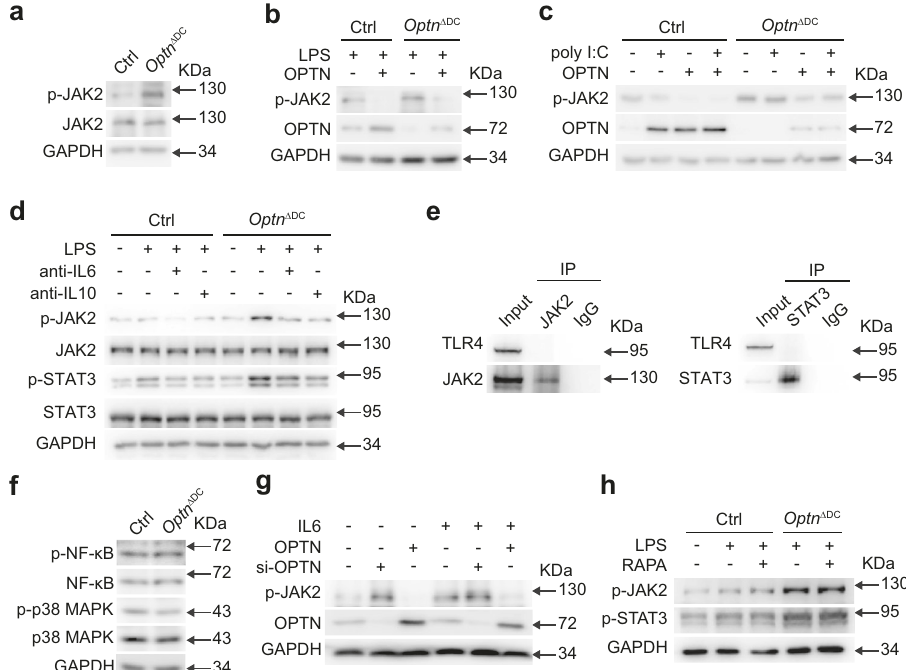
Fig. 6 OPTN restrains the IL-6/IL-10 activated JAK2/STAT3 phosphorylation in DCs. a Expression of (p)-JAK2 in Ctrl or Optn de fi cient BMDCs stimulated with LPS for 8 h. b , c Ctrl and Optn de fi cient BMDCs were stimulated with LPS ( b ) or poly I:C ( c ) after transfection with empty or OPTN expression vector. The expressions of OPTN and p-JAK2 were con fi rmed by western blotting. d Western blotting for expression of (p)-JAK2 and (p)- STAT3 in Ctrl and Optn de fi cient BMDCs stimulated with anti-IL6 or anti-IL10 for 48 h. e Interaction between endogenous TLR4 and JAK2 or STAT3 in BMDCs was analyzed by IP with anti-JAK2 or anti-STAT3 using normal rabbit IgG as a control, followed by immunoblotting with anti-TLR4, anti-JAK2, and anti-STAT3. f Expression of (p-) signaling proteins in whole-cell lysates of Ctrl or Optn de fi cient BMDCs stimulated with LPS. g HEK293 cells were transfected with si-Optn or Optn plasmid before IL-6 stimulation. The expressions of OPTN and p-JAK2 were con fi rmed by western blotting. h Western blotting for expression of p-JAK2 and p-STAT3 in Ctrl and Optn de fi cient BMDCs stimulated with RAPA. All data are representative of three independent experiments. Source data are provided in Source data fi